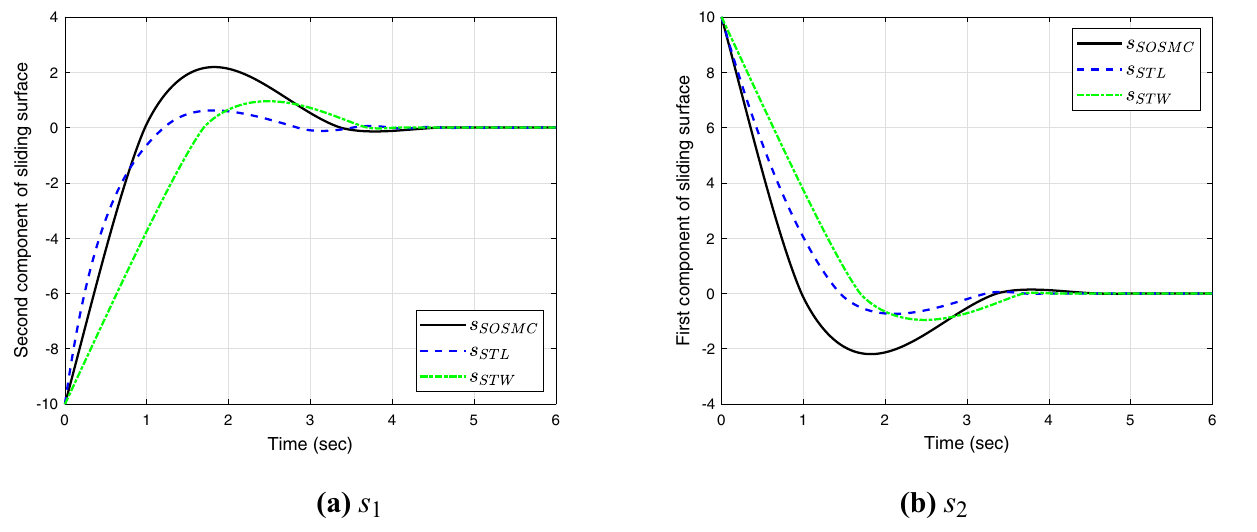
Fig. 11 Comparison of sliding surface variables s 1 and s 2 for SOSMC, STW and